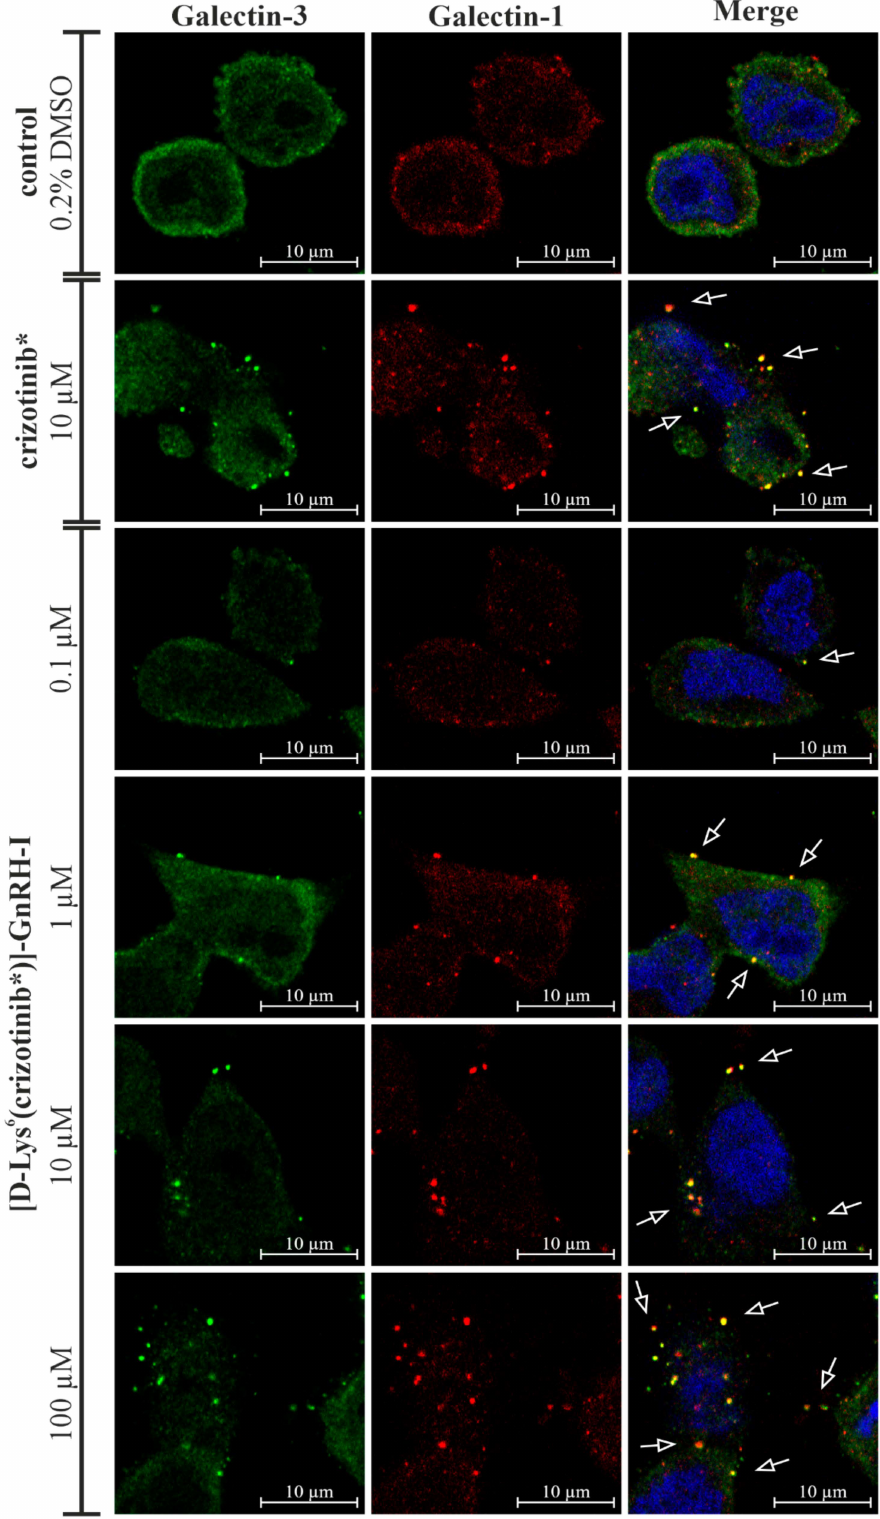
Figure 8. Galectin puncta assay for crizotinib* and [ d -Lys 6 (crizotinib*)]–GnRH-I in EBC-1 cells. Galectin-3 and galectin-1 puncta formation indicate lysosomal membrane damage. Galectin-3: green (Alexa Fluor 488); galectin-1: red (Alexa Fluor 594); nuclei: blue